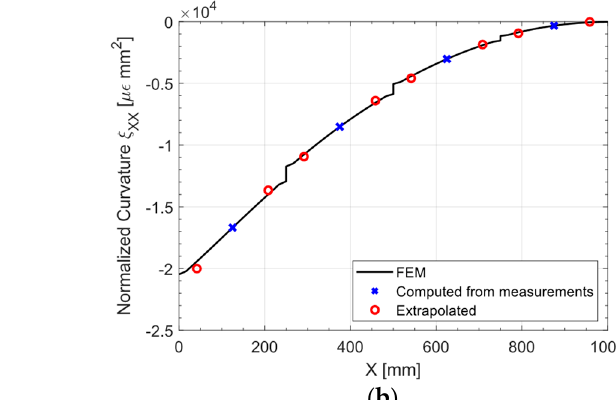
Figure 15 . Uniform pressure: ( a ) curvature 𝜅 (cid:3025)(cid:3025) and ( b ) normalized curvature 𝜉 (cid:3025)(cid:3025) , slice at Y = 250 mm.